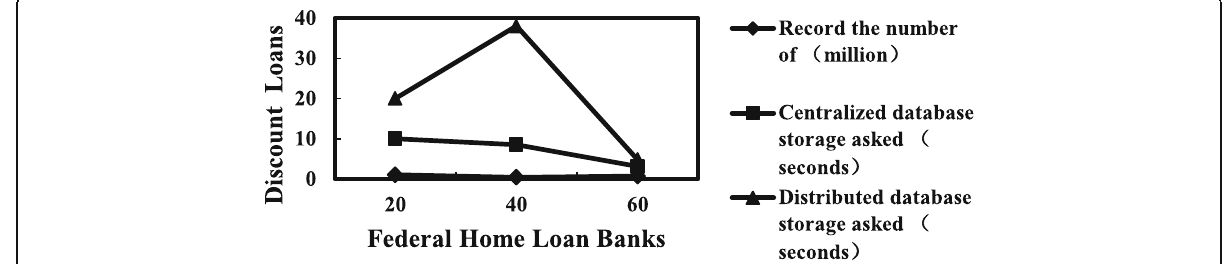
Fig. 3 Distributed database data distribution optimization algorithm contrast